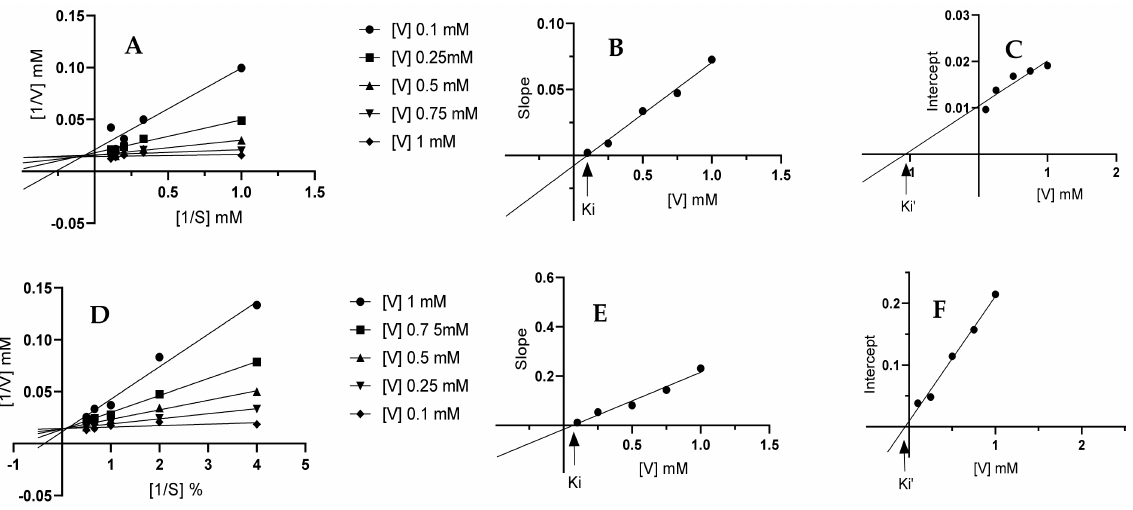
Figure 6. Kinetic analysis of α -glucosidase ( A – C ) and α -amylase ( D – F ) inhibition against various concentrations of 12i . Enzyme reaction velocity (V, 1/V) is given in